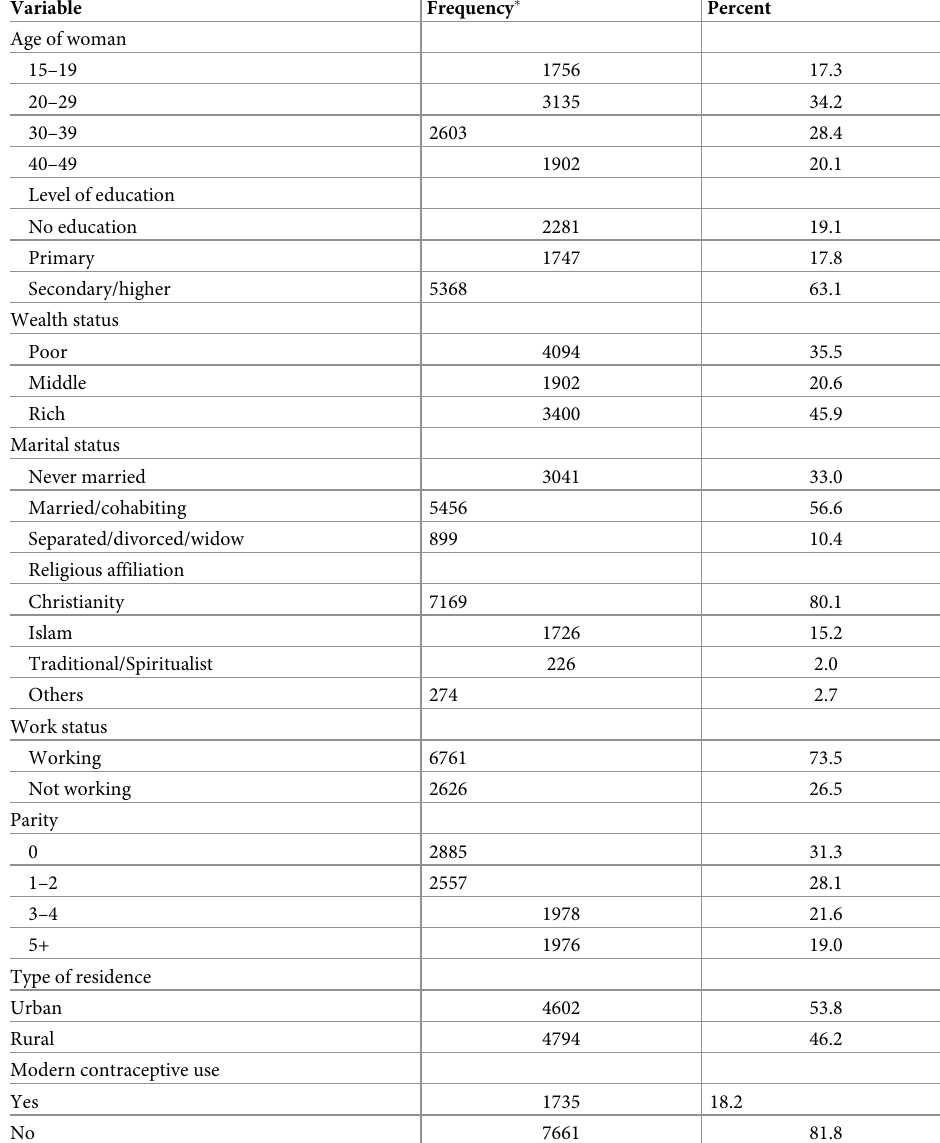
Table 1. Background characteristics of